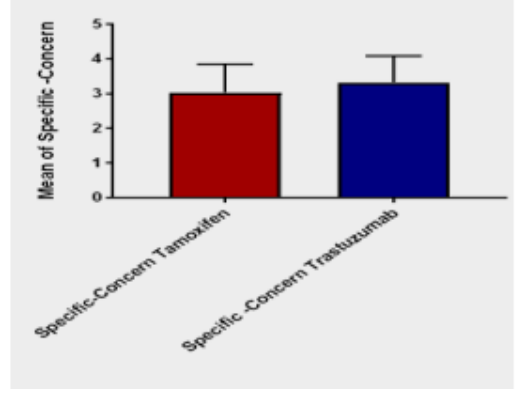
Figure 2. Mean of Specific-Concern for Tamoxifen and Trastuzumab.